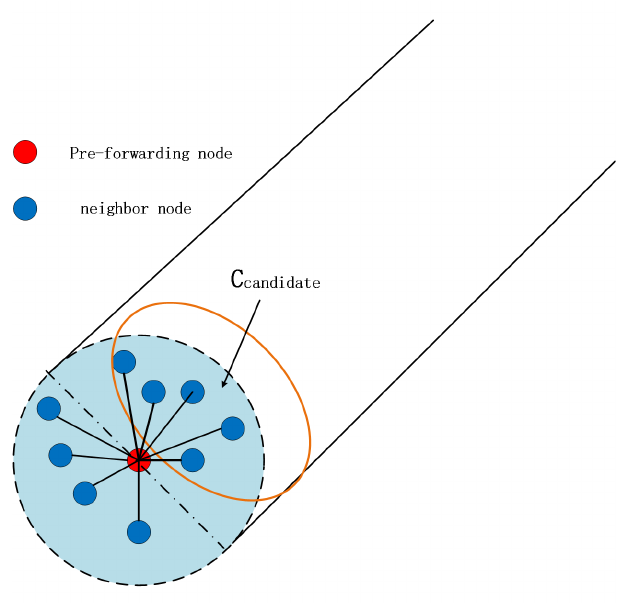
Figure 5. The schematic diagram of candidate relay